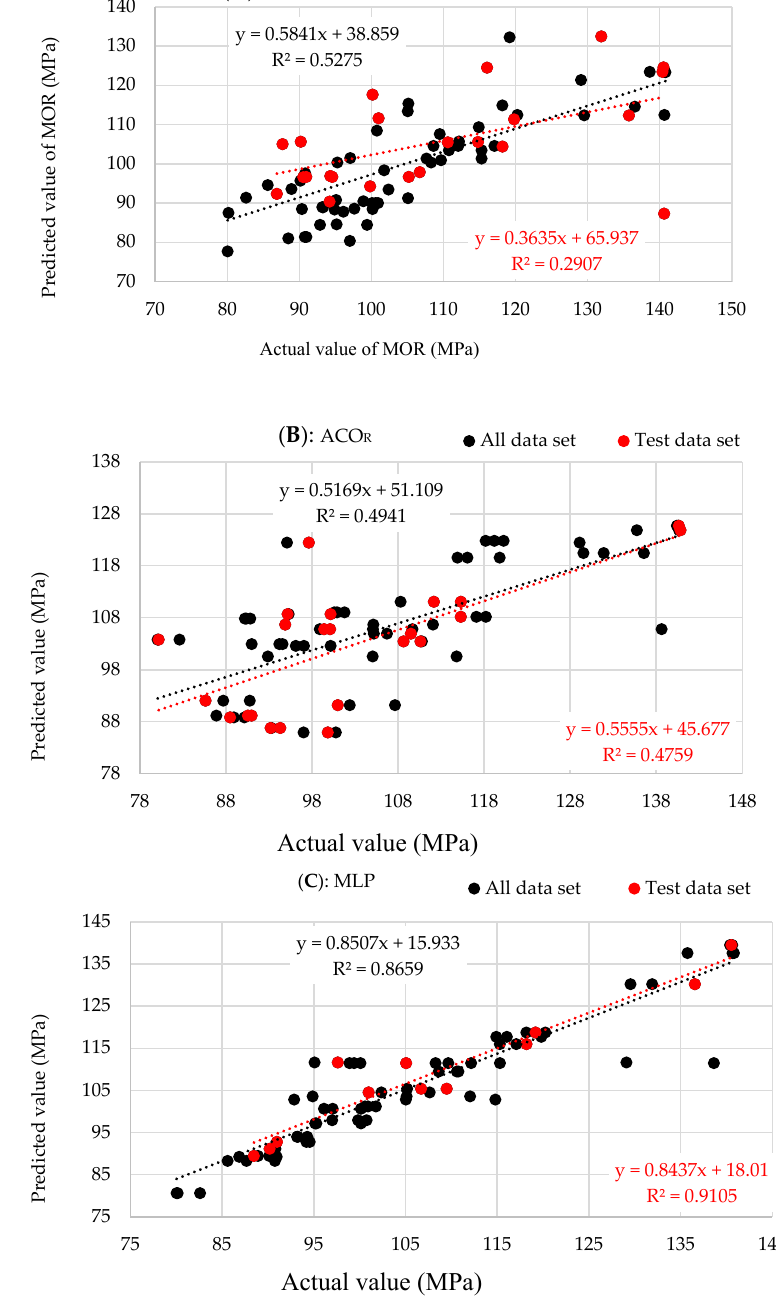
Figure 2. Comparison of the measured and predicted MOR (MPa) for the testing and all data sets using ( A ) MLR, ( B ) ACO R and ( C ) MLP. The R 2 results of the MLP show that the developed model’s data match at least 91% of the measured MOR data. Additionally, the MLR and ACO R have a lower R 2 value, in- dicating that 52.75% and 49.41% of the changes in MOR can be explained by the MLR and ACO R models. Hence, the analysis of the data given in Figure 2 shows that the MOR pre- diction of MLP achieves a higher accuracy compared to the MLR and ACO R . The high R 2 values of the MLP emphasize the excellent agreement between the measured and pre- dicted outputs of the MOR, and the high validity of the MLP in this study. Based on the MLR and ACO R , we see that the models achieve a rather weak performance. High R 2 values do not always mean that the regression model is efficient. Other val- ues, such as RMSE, MAE and SSE, are also used to validate and compare more than one model. In a good model, the MAE and SSE must be as small as possible, while the RMSE must be close to zero. Higher RMSE, MAE and SSE values mean a larger probability of error in the prediction. The RMSE values are 5.16, 6.31 and 5.83, respectively, for the test- ing, training and all data sets. However, in MLR and ACO R modeling, the RMSE values are 2- to 3-fold greater than the values of the MLP method for all three items. The MAE values of the testing, training and all data sets obtained by MLP modeling (3.59, 3.58 and 3.44, respectively) are significantly lower than those obtained by the MLR and ACO R mod- els. At the same time, it is observed that the SSE values of the MLP model are significantly lower (2660, 2152 and 319, respectively, for the testing, training and all data sets) than those obtained by MLR and ACO R modeling. Hence, the statistics indicate that, according to its stronger ability to predict the response, the MLP can be used for modeling and esti- mating the response with the greatest accuracy and reliability. Table 4. The statistics resulting from the testing, training and all data sets based on the MLR, ACO R and MLP approaches. Source